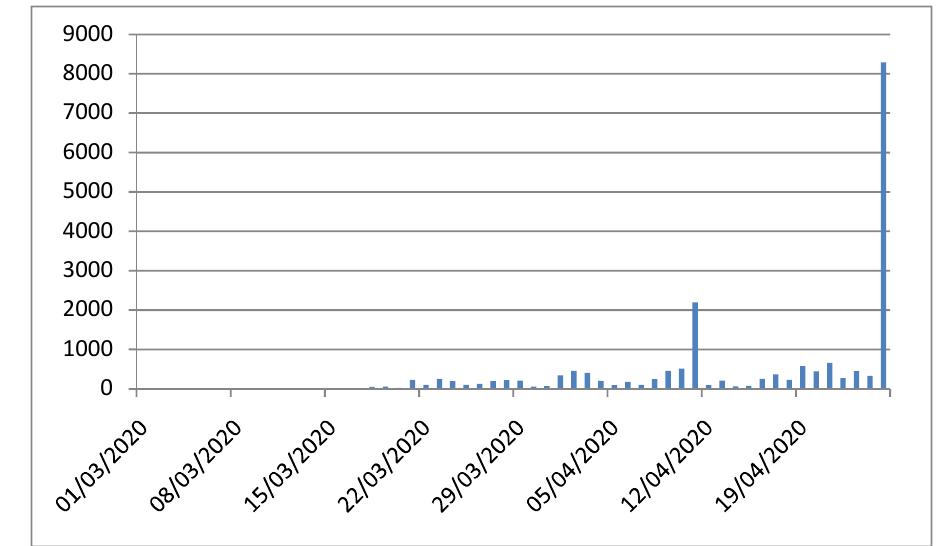
Figure 2 – Histogram of the infected people on a daily basis in Colombia in March